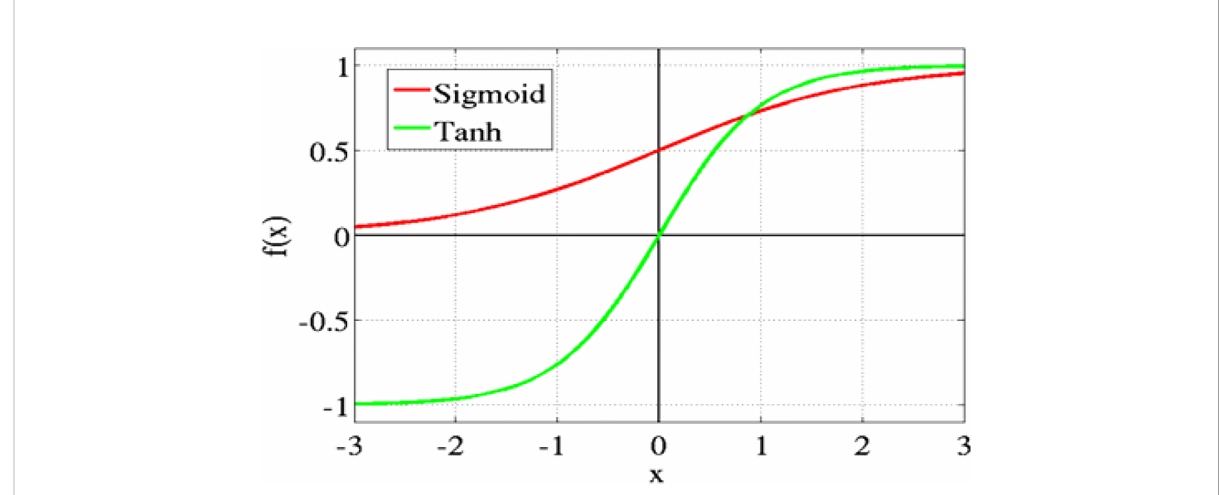
FIGURE 9 Hyperbolic tangent